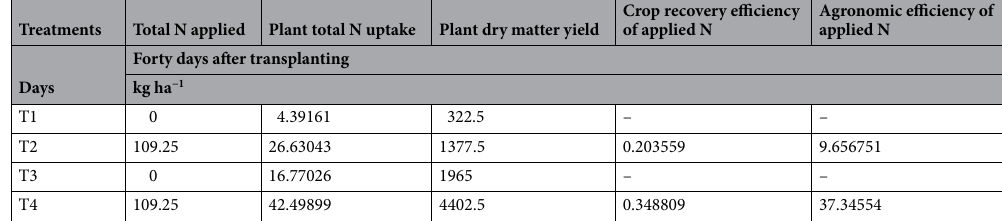
Table 17. Chicken litter biochar application and split application of urea on crop recovery and agronomic efficiency on day forty after transplanting.